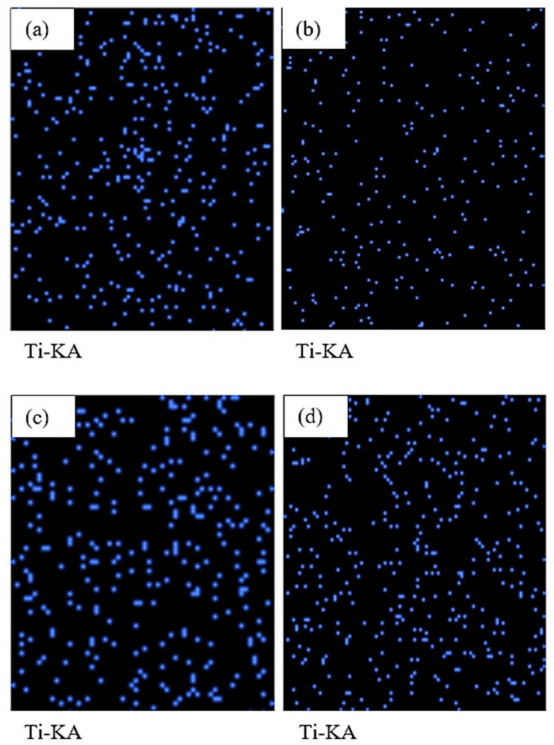
Figure 2. NH 2 -MIL-125(Ti)/CTA HFMMMs spun at various air gap distances of ( a ) 1 cm, ( b ) 3 cm, ( c ) 5 cm, and ( d ) 7 cm.